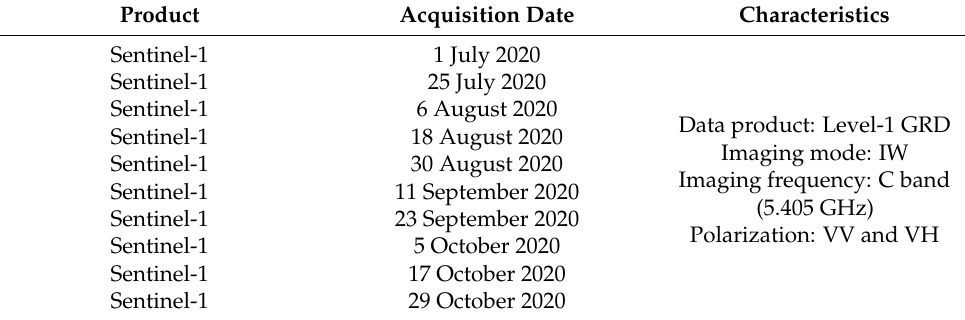
Table 1. Sentinel-1 SAR data.